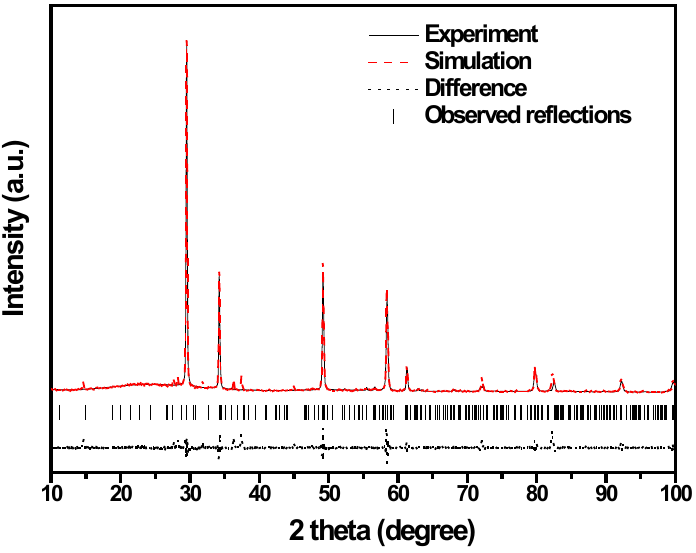
Table 3. Structural parameters of ZnBiSbO